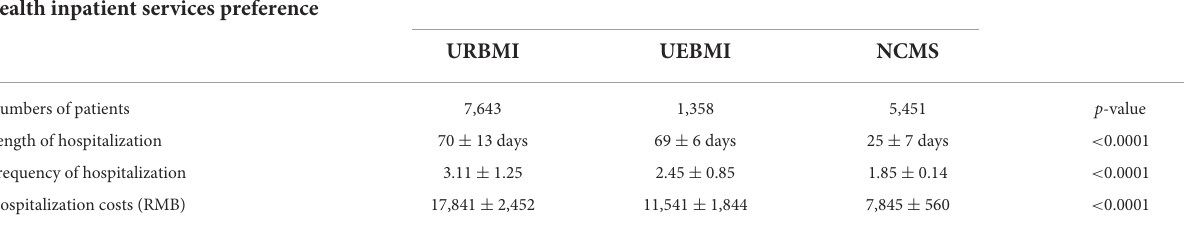
TABLE 9 Mental health inpatient services preference disparities in the utilization according to the nature of insurance.